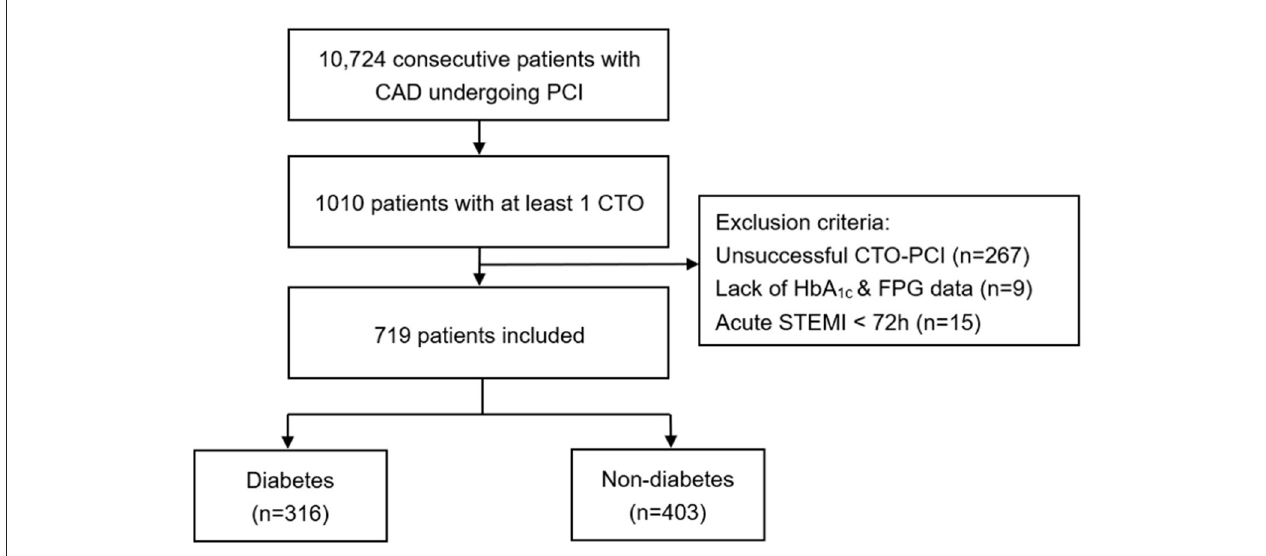
FIGURE 1 | Study flow chart. CAD, coronary artery disease; PCI, percutaneous coronary intervention; CTO, chronic total occlusion; HbA1c, hemoglobin A1c; FPG, fasting plasma glucose; STEMI, ST-segment elevation myocardial